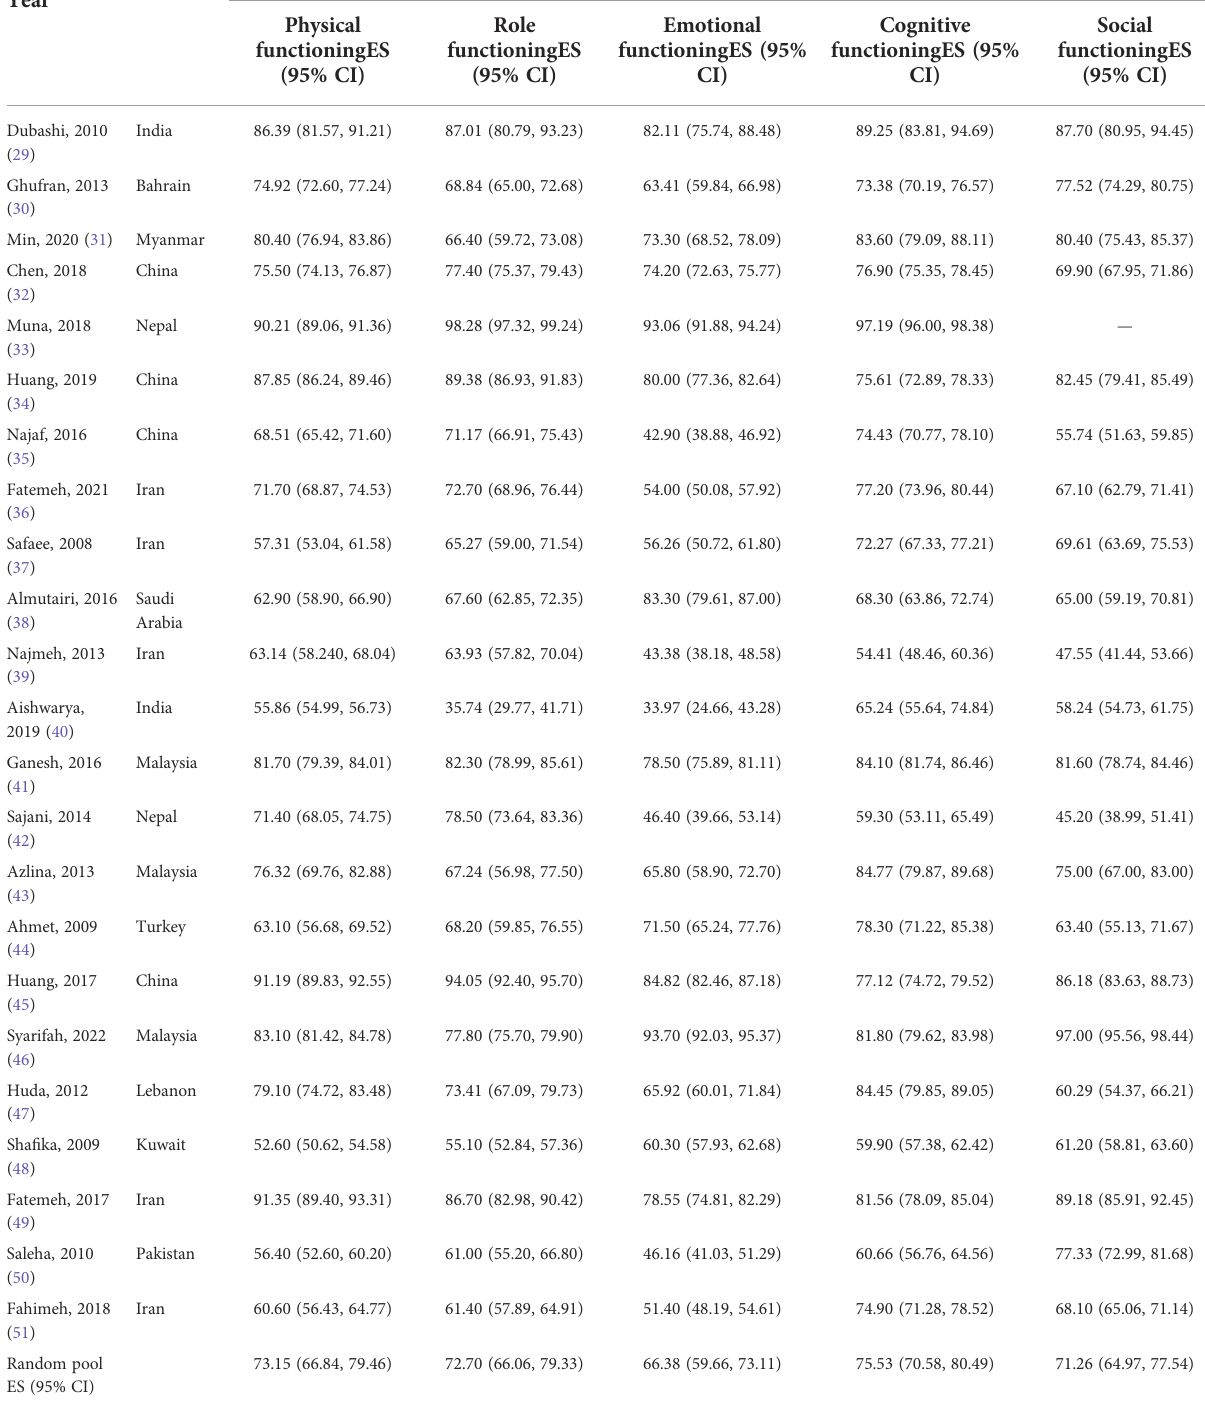
TABLE 2 Functional subscales of EORTC QLQ-C30. Study